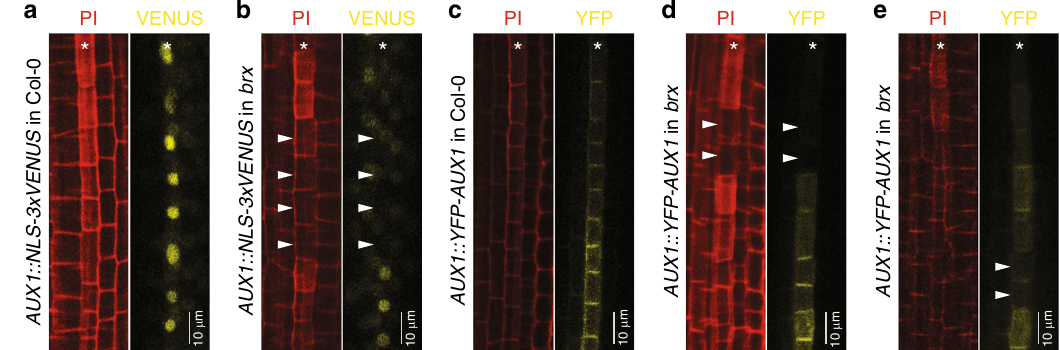
Fig. 4 AUX1 expression in brx mutants. a – e Confocal microscopy images of developing PPSE cell fi les (asterisks); left panels: propidium iodide cell wall staining (red); right panels: reporter fl uorescence (yellow). a , b Transcriptional reporter of AUX1 gene expression in developing PPSEs of Col-0 wild type ( a ) or brx ( b ). c – e Expression of YFP – AUX1 fusion protein in wild type ( c ), the brx differentiation zone ( d ), and the brx early meristematic zone ( e ). Gap cells in brx are marked by arrowheads in b and d , cells with low AUX1 are marked by arrowheads in e